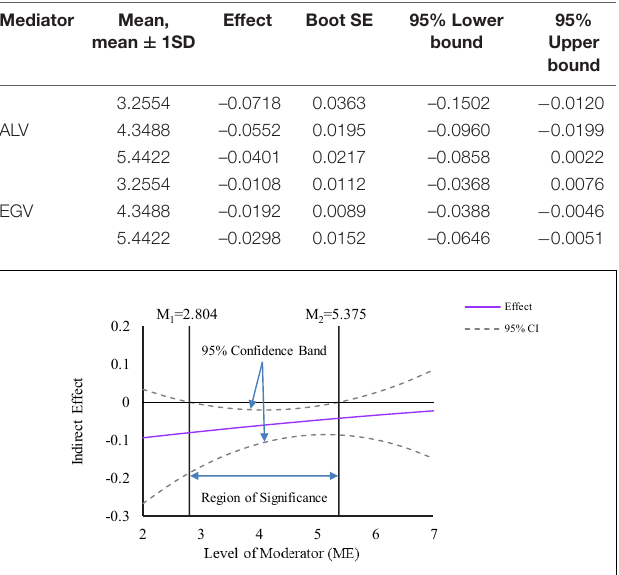
FIGURE 5 | Moderated mediation effect of Media exposure (ME) (mediator = ALVs).